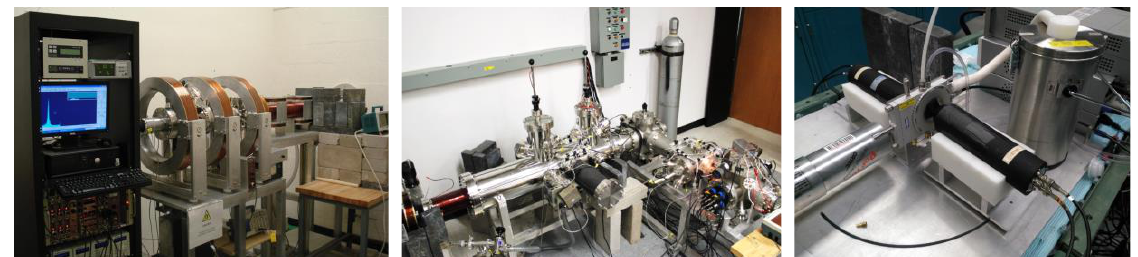
Fig. 4. the e + -PAS spectrometer (left), Ps-PAS spectrometer (center), and bulk spectrometer (right).